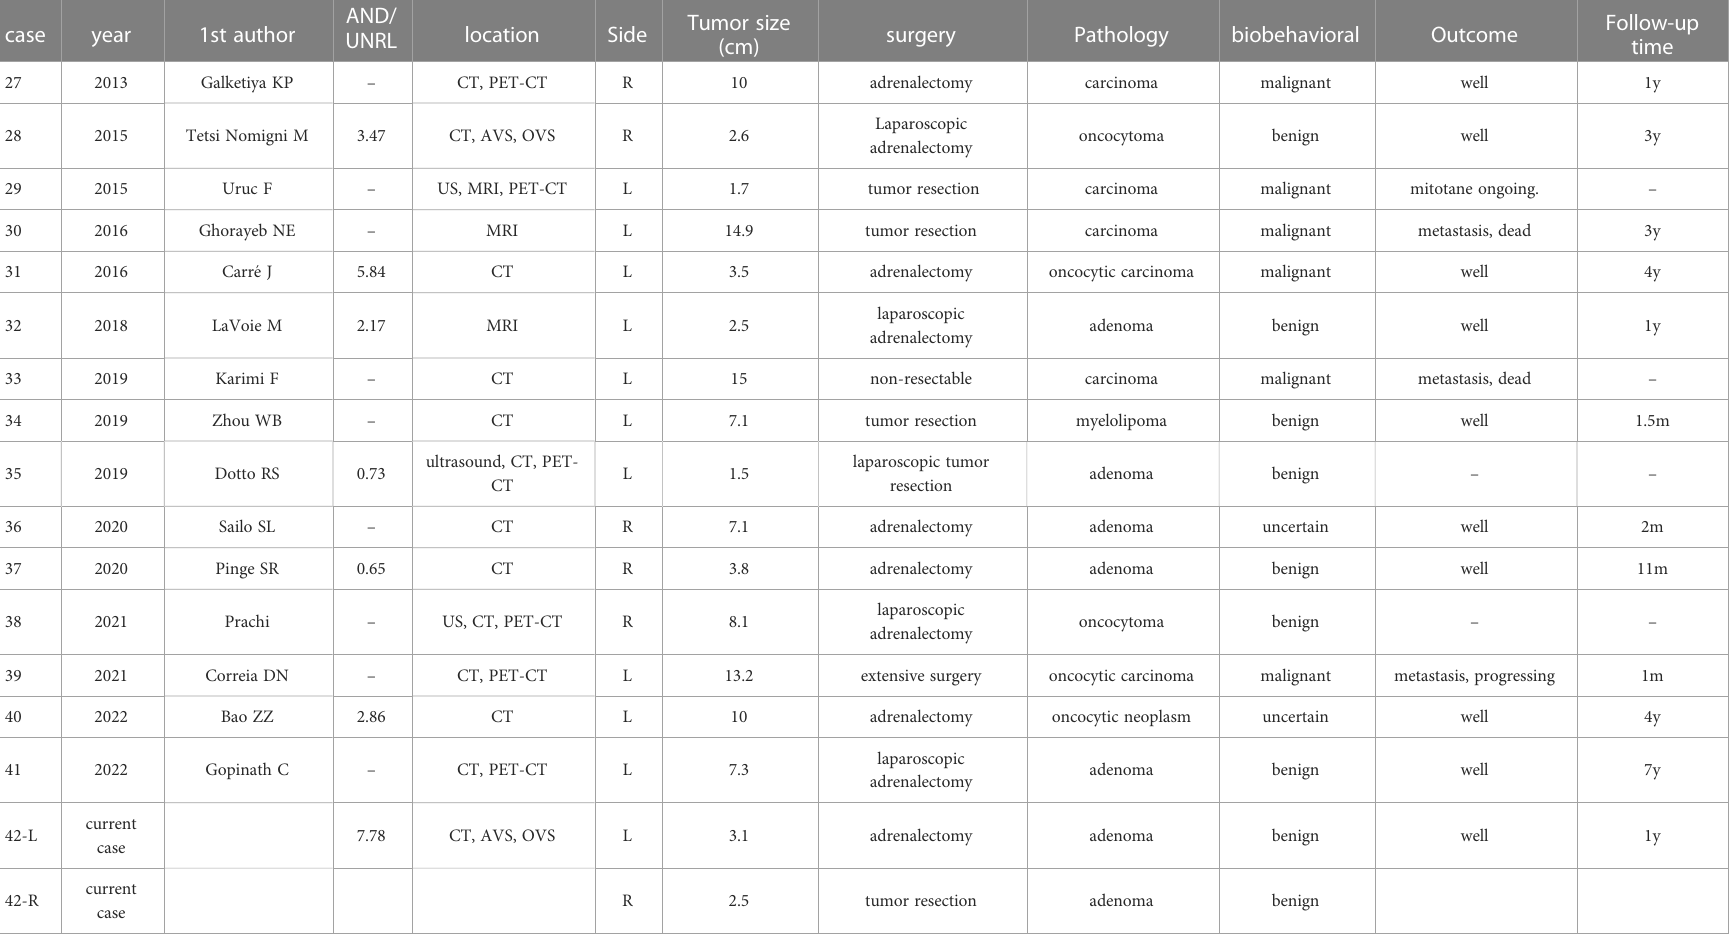
2.5 tumor resection adenoma